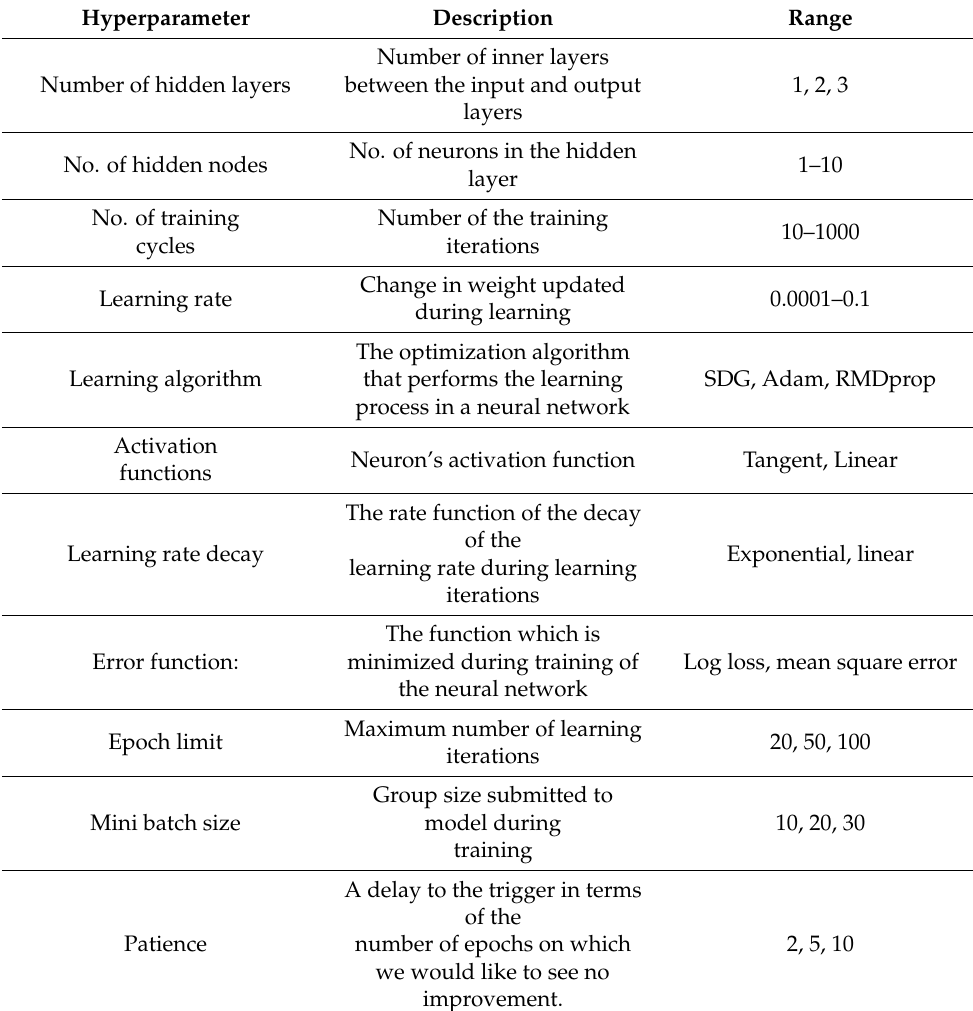
Table 3. Hyperparameters and their range for ANN